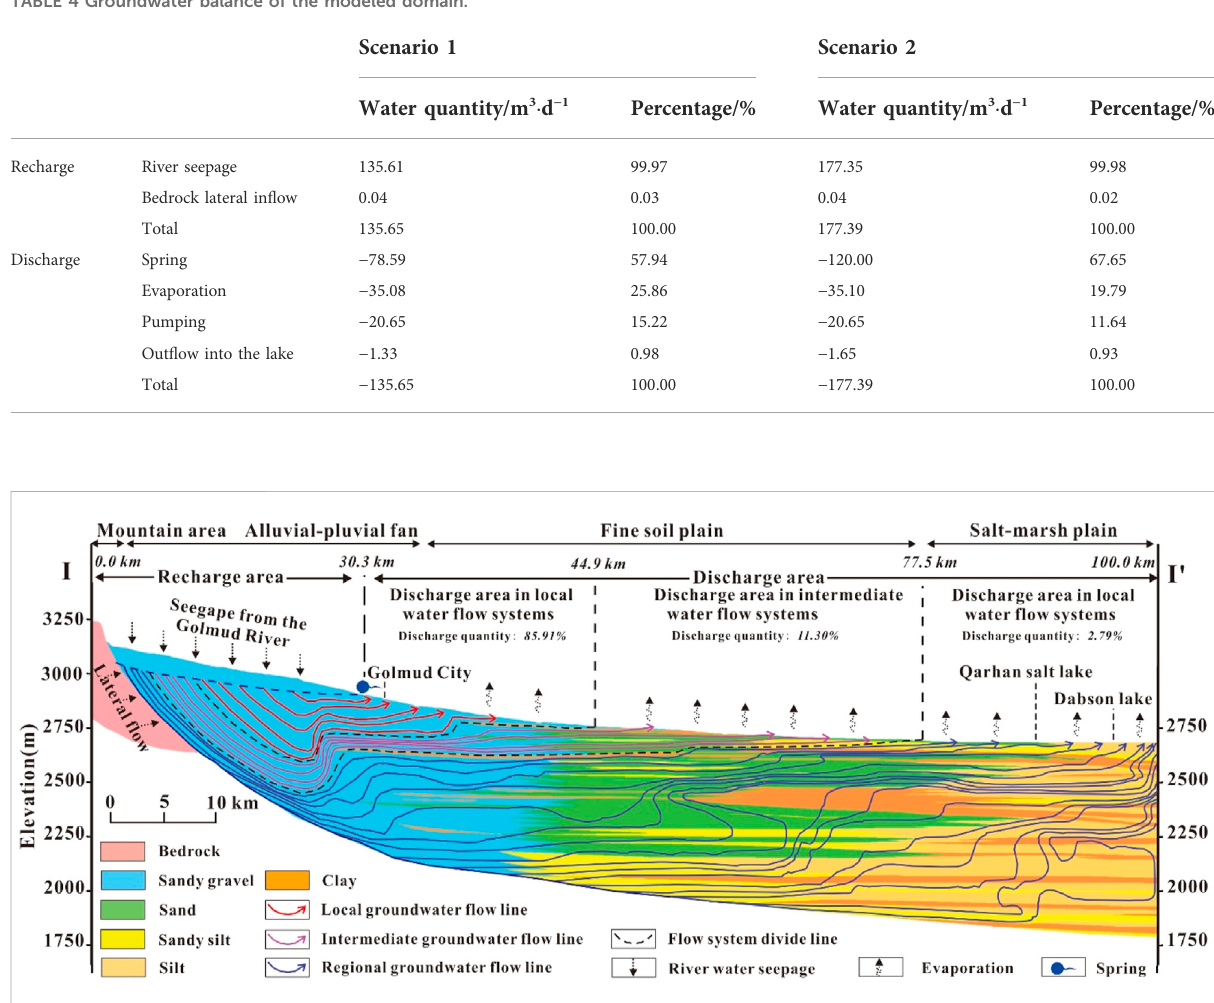
TABLE 4 Groundwater balance of the modeled domain.